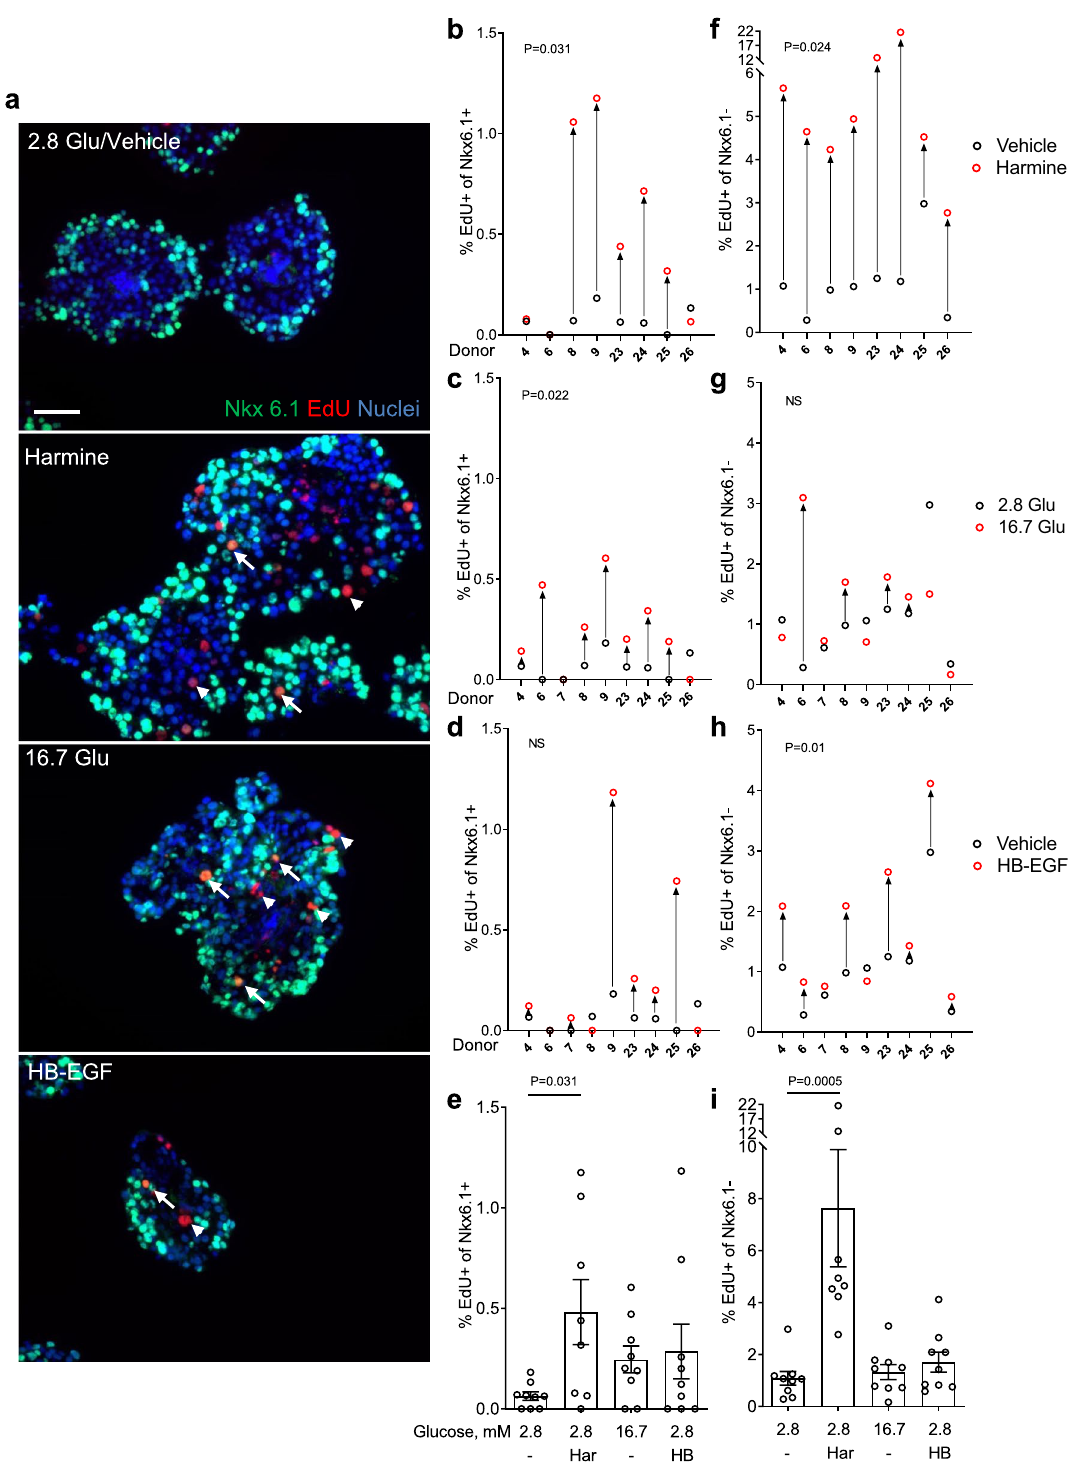
Figure 2. Analysis of β-cell proliferation in intact human islets by immunohistochemistry for Nkx6.1. ( a – i ) Intact human islets were exposed to 2.8 mM glucose (Vehicle or 2.8 Glu; a – i ), harmine (10 μM) (Har; a , b , e , f , i ), 16.7 mM glucose (16.7 Glu; a , c , e , g , i )